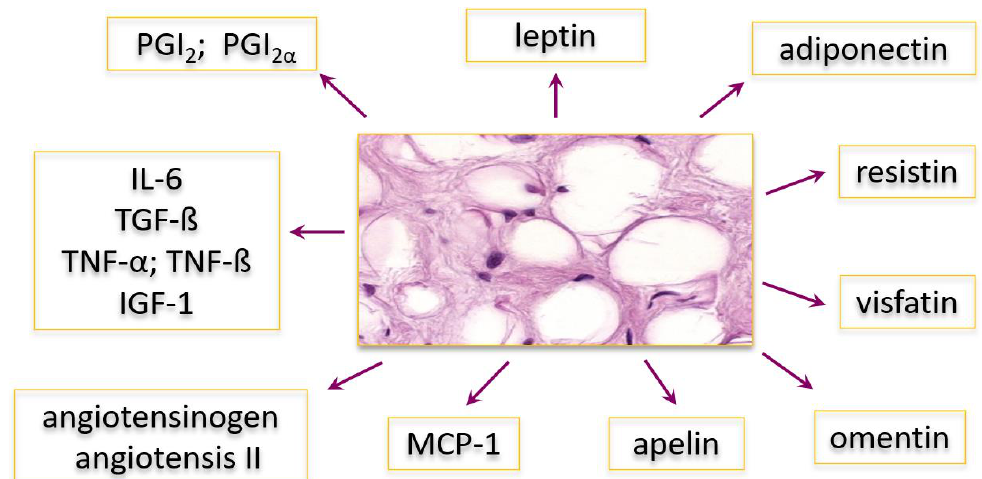
Figure 1. The main adipokines synthesized and secreted by adipocytes of white adipose tissue. Various type of adipokines are presented, including hormones, cytokines, and other biologically active substances: PGI—prostaglandins I2 and I2alpha; IL-6—interleukin 6; TGF-ß—transforming growth factor beta; TNF-α and TNF-ß—tumor necrosis factor alpha and beta; IGF-1—insulin-like